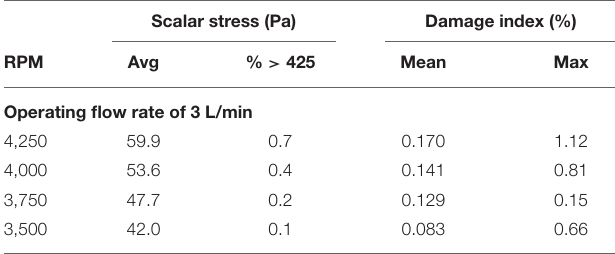
TABLE 1 | Fluid stress level and blood damage index estimations for the centrifugal pump model.